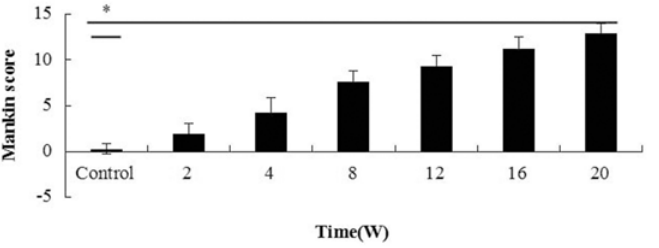
Fig 9. The Mankin score increased at the different time points after surgery with improved Hulth method. Asterisks indicate significant